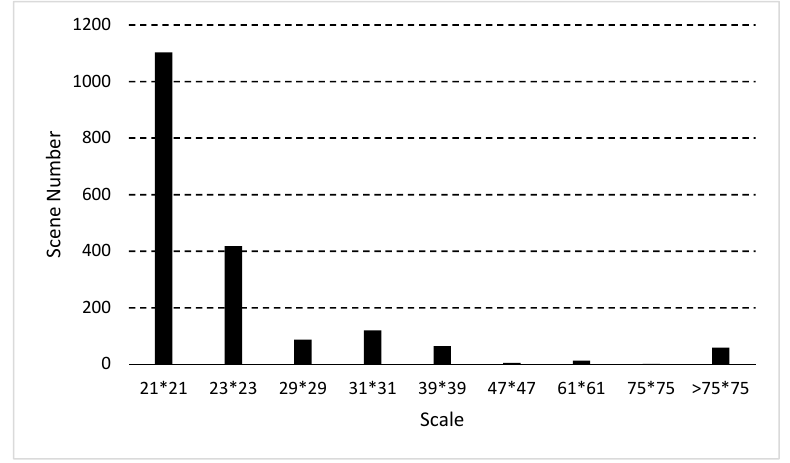
Figure 2. The proper aggregation scale histogram according to the sill value of each scene. The scale is defined with TM pixels. The scene number is the total number of the scenes at each scale where the MODerate Resolution Image Spectroradiometer (MODIS) pixel represents the spatial scale well.